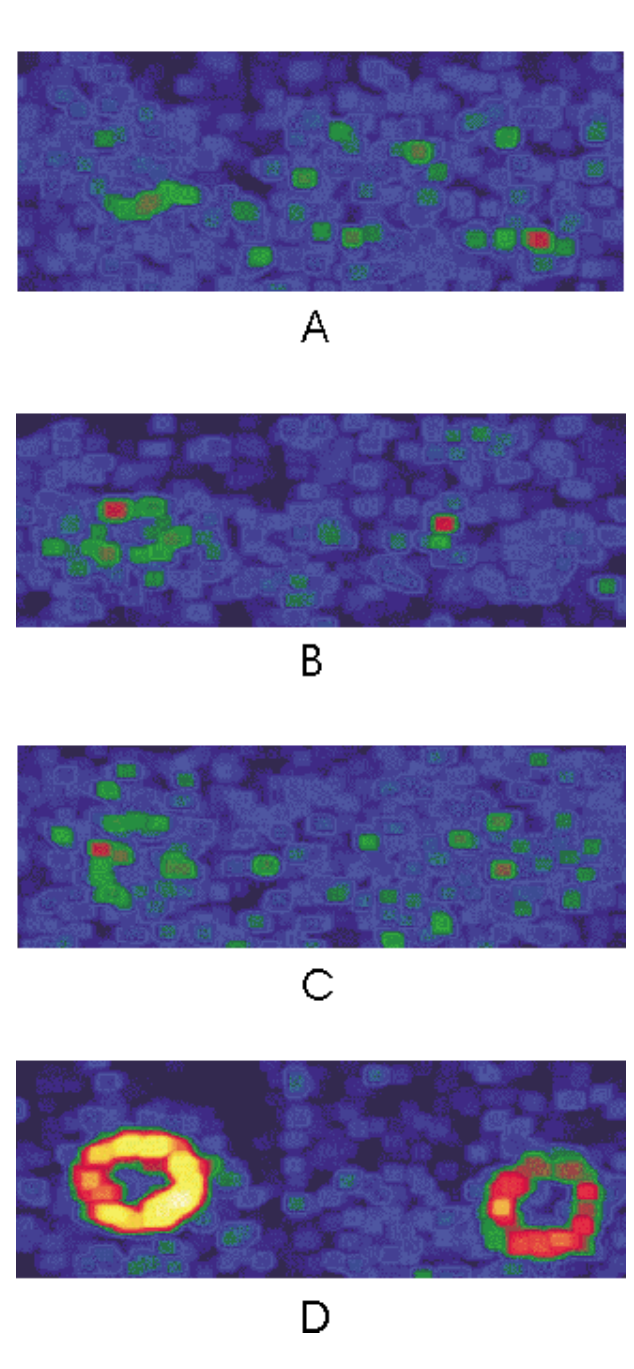
Fig. 3A, B, C and D – Sequence of difference frames showing in time/space the evolution of the red and blue scatter at the critical transition before propagation. The difference frames were taken with a 240msec interval. In the sequence we show the second, the fifth the thirteenth and the nineteenth differences from a original sequence of 19 difference frames, available to reader at the Internet (www.lsi.usp.br/ ∼ bioinfo/) . The frames were chosen to show the peaks in the red scatter signal. The last frame shows the amplification in both time and space just at the transition to propagating wave.